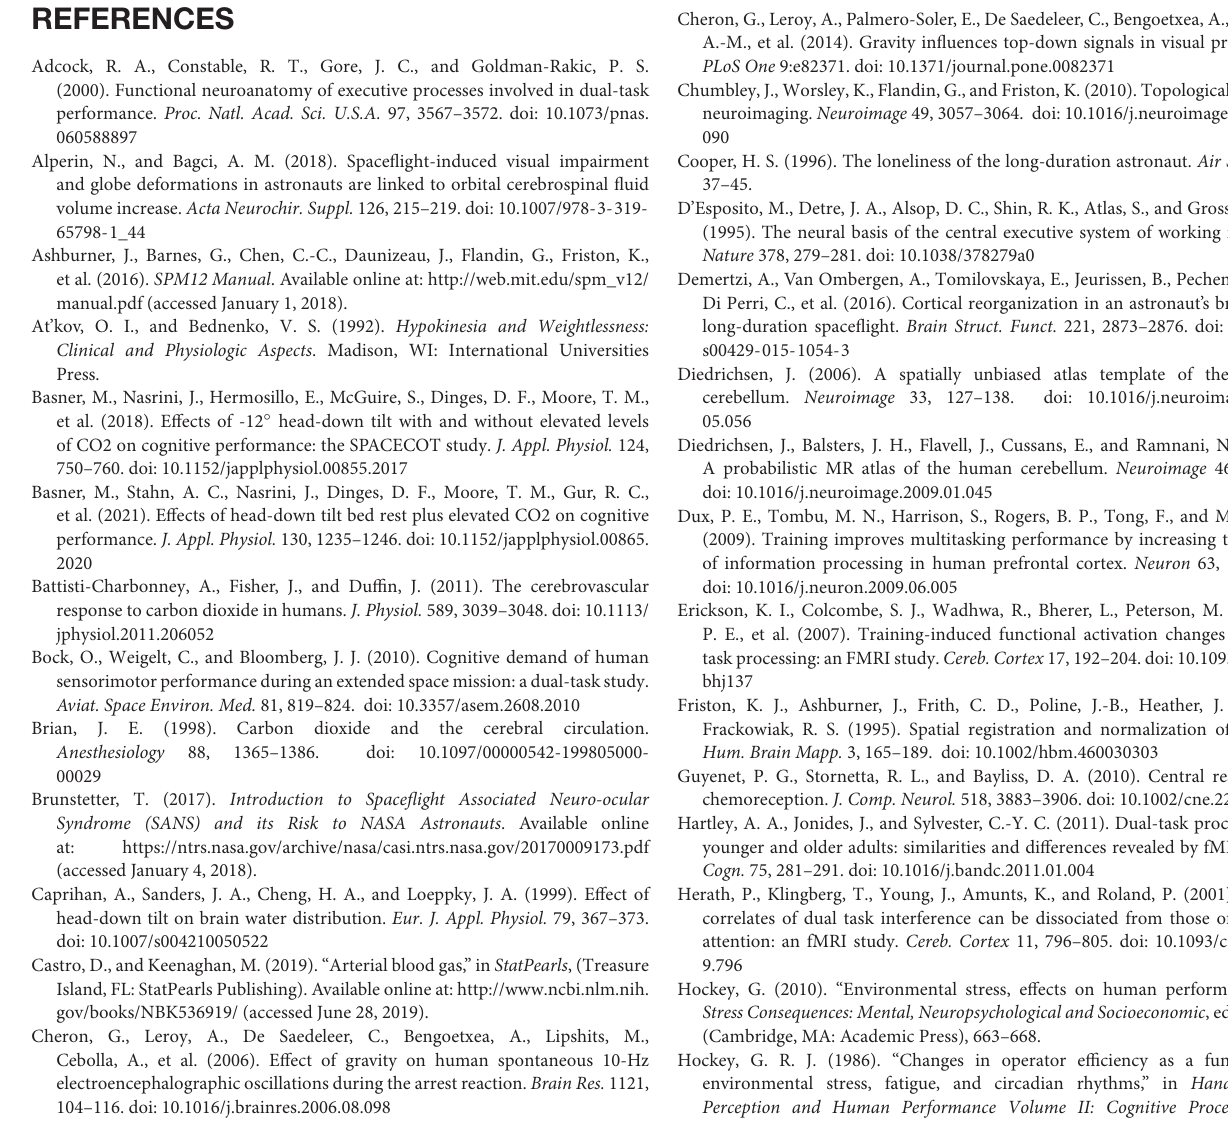
Supplementary Figure 1 | Longitudinal change in DTCost of brain activation (Cerebellum). Cerebellar clusters that exhibited longitudinal patterns of change matching the hypothesized Instant Decrease with Recovery in-Bed Rest Model. Analyses were conducted at an uncorrected alpha level of p < 0.0001. Supplementary Figure 2 | Longitudinal change in brain activation (left superior frontal gyrus). Comparison of longitudinal changes in DTCost and its constituent TAP, COUNT, and DUAL tasks within the left superior frontal